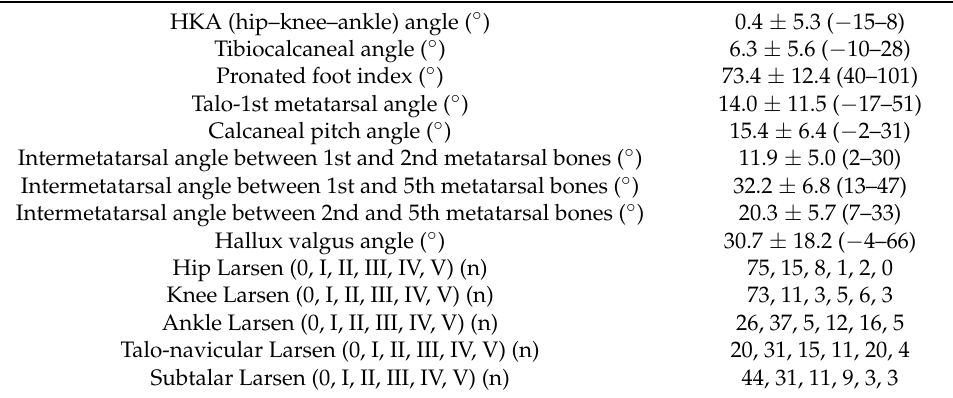
Table 2. Values of alignment/destruction